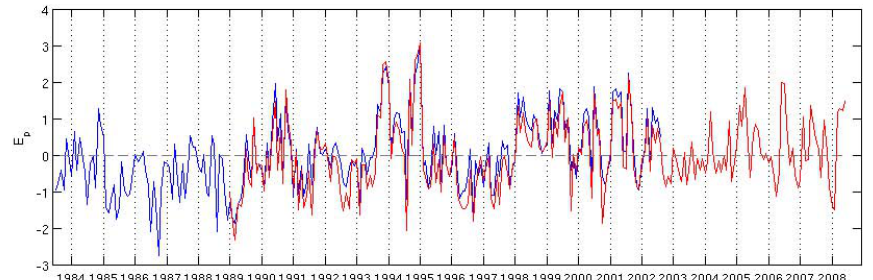
Fig. 6. Normalised anomaly of Penman potential evaporation, computed by data from our radiation transfer model, and ERA-40 (blue line) or ERA Interim (red line).